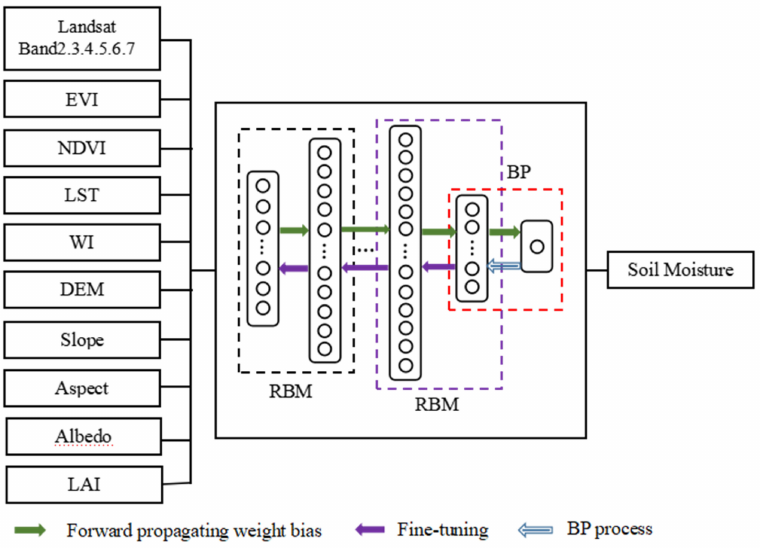
Figure 4. SMD-DBN